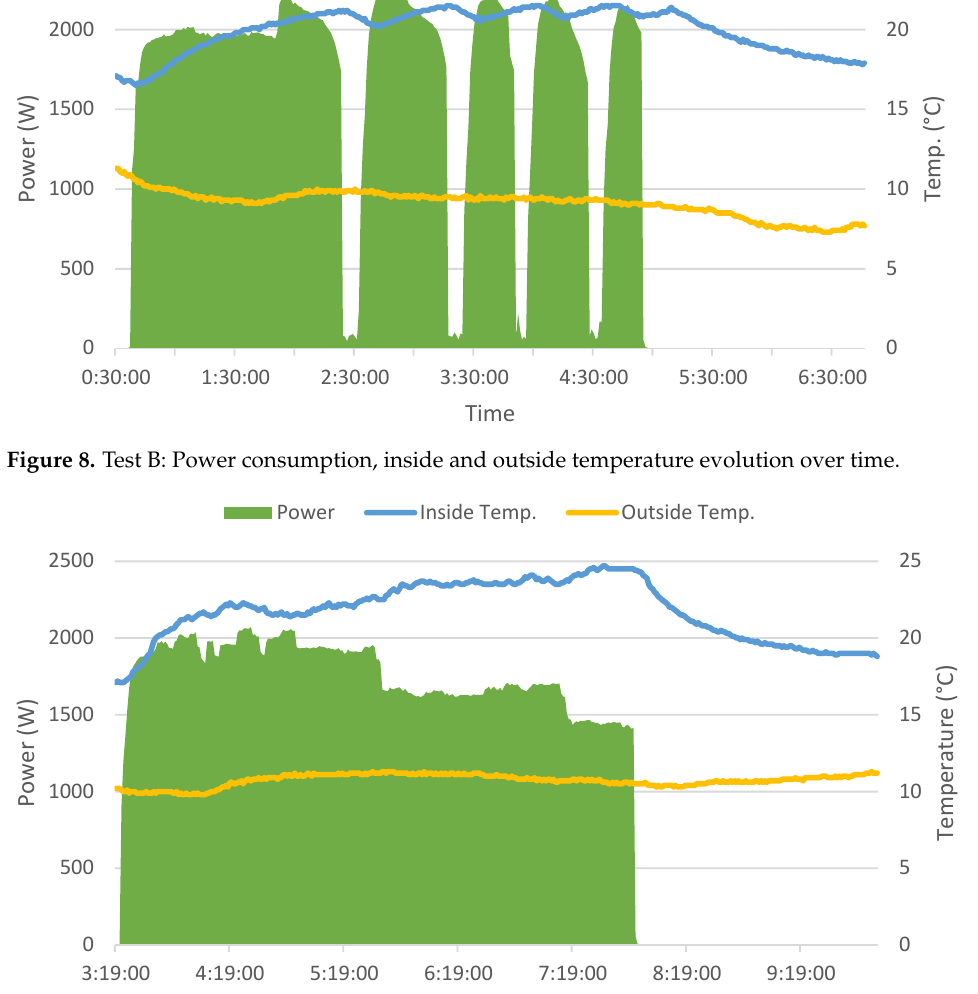
Figure 9. Test C: Power consumption, inside and outside temperature evolution over